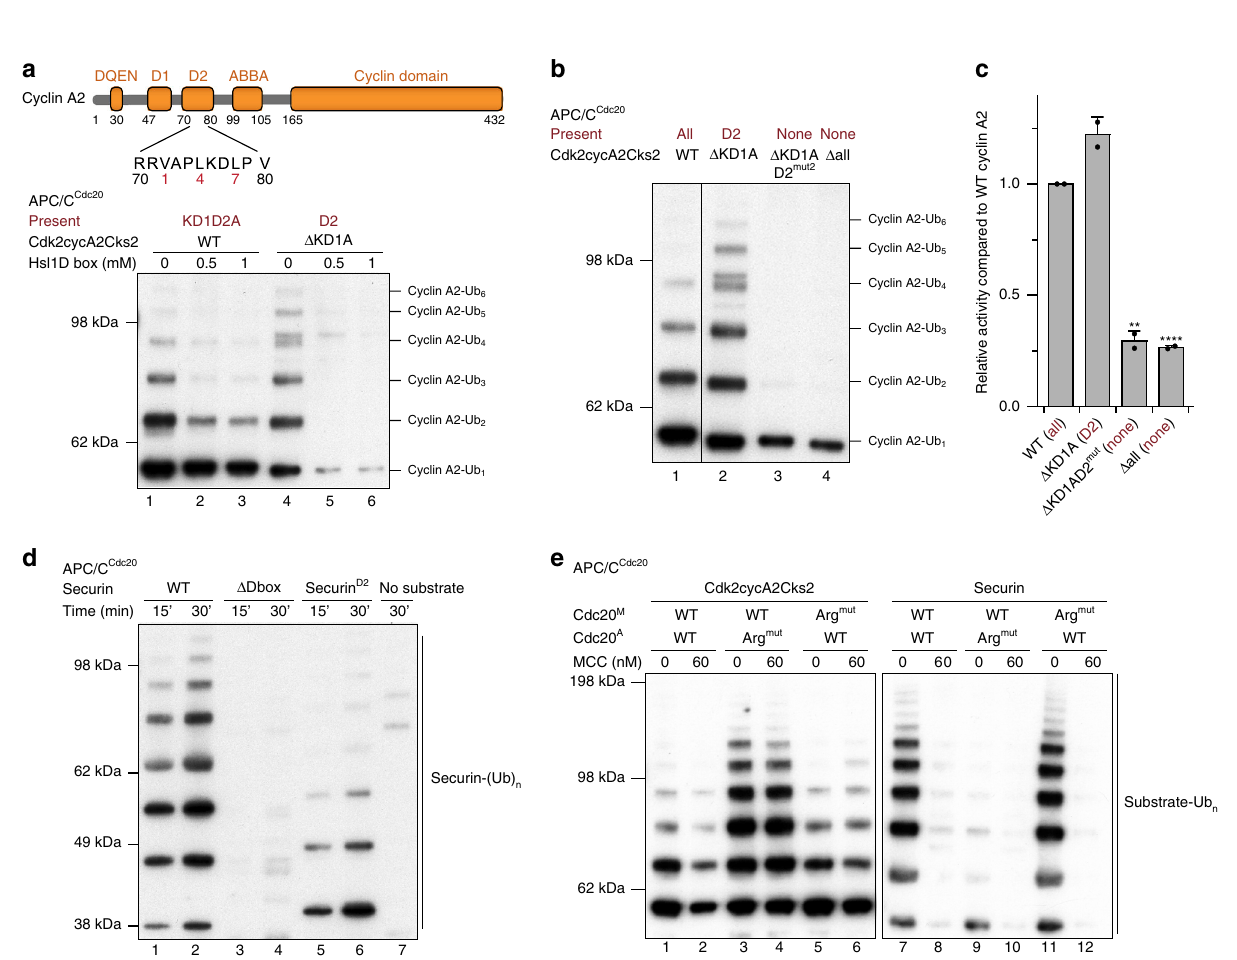
Fig. 2 An unidenti fi ed degron conserved among mammals is present in cyclin A2. a Mutation of all three known degrons (KEN box, D1 box and ABBA motif) in cyclin A2 did not impair cyclin A2 ubiquitination by APC/C Cdc20 (compare lanes 1 and 4). However, the mutant cyclin A2 Δ KD1A is subject to MCC-imposed inhibition (lanes 4 – 6), similar to Cdk2-cyclinB1-Cks2 (lanes 7 – 9). The remaining degrons in cyclin A2 after the mutation are labelled in dark red. b Replacing overlapping segments within residues 60 – 80 of cyclin A2 with GSA-linkers identi fi ed that residues 70 – 80 may contain an unidenti fi ed degron. Mutation of either residues 65 – 75 or 70 – 80 in addition to Δ KD1A severely impaired cyclin A2 ubiquitination by APC/C Cdc20 . c , d Degradation pro fi les of the eGFP-cyclin A2 mutants where either the KD1A degrons (leaving the D2 box present) or all four degrons were mutated in HEK cells under unperturbed mitosis ( c ) and a SAC arrest using STLC ( d ). Degradation pattern of cyclin B1 was recorded as a reference. The total eGFP fl uorescence minus background fl uorescence for each cell at each time point was normalized to NEBD, quanti fi ed and plotted over time. The timepoints of NEBD and reversine addition to release the SAC arrest are marked, respectively. Error bars indicate mean ± standard deviation of n = 62 wild-type cyclin A2, 24 Δ KD1A, 37 Δ all and 45 wild-type cyclin B1 cells under unperturbed mitosis and 13 wild-type cyclin A2, 11 Δ KD1A and 19 Δ all cells under a SAC arrest from three experiments. e Addition of a peptide modelled on residues 60 – 80 of cyclin A2 inhibited ubiquitination of the cyclin A2 Δ KD1A mutant, con fi rming that this region targets cyclin A2 for ubiquitination. f , g Sequence alignment of the N-terminal domain of cyclin A2 and phylogenic tree. Positions of the four degrons are indicated. All cyclin A2 sequences used in the sequence alignment contain the D1 box (except for mouse and rat), whereas the D2 box appeared at a later stage of evolution. Source data are provided as a Source Data fi le